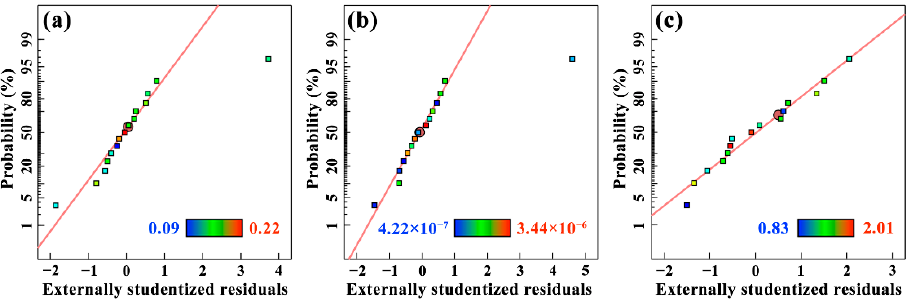
Figure 4. Normal probability plot of residual for ( a ) μ , ( b ) W r and ( c ) R